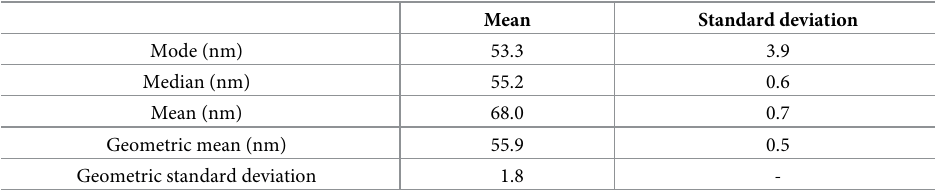
Table 2. Size distribution of the aerosol during